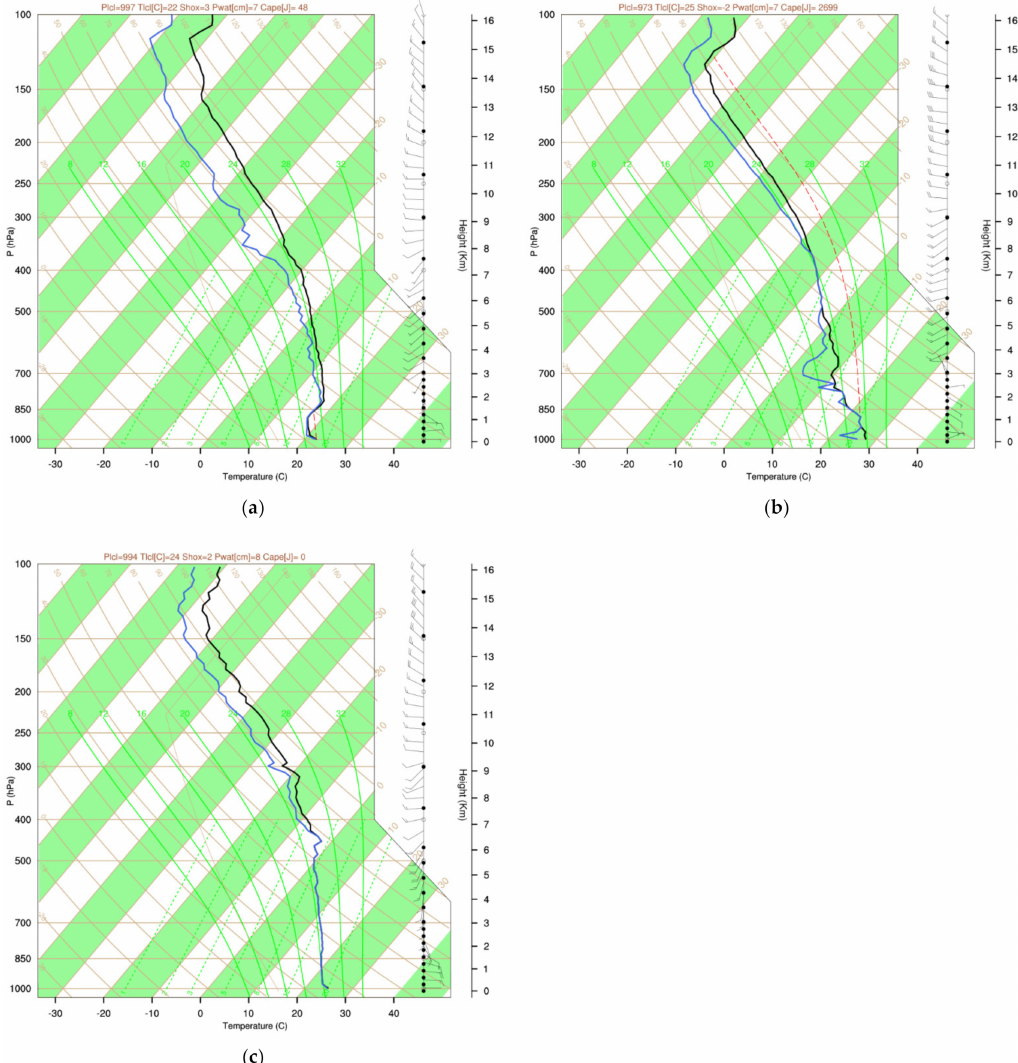
Figure 3. Profiles of temperature (black line) and dew point temperature (blue line) at Fuyang station (red dotted line represents the pseudoadiabat curve). ( a ) 1300 LST 22 June; ( b ) 1900 LST 27 June; ( c ) 1300 LST 11